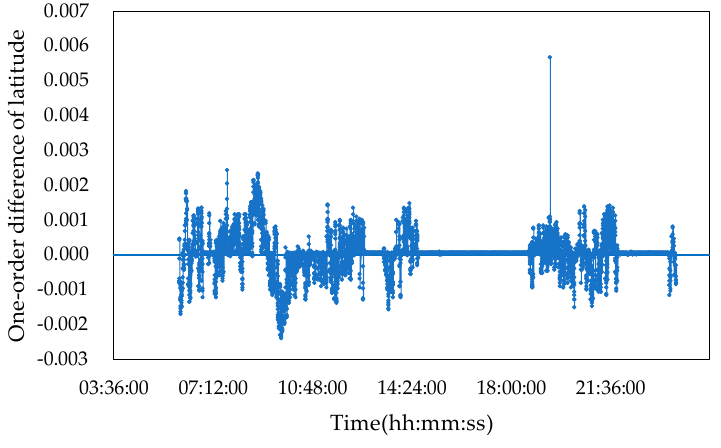
Figure 8. The time series graph of the one-order latitude difference.